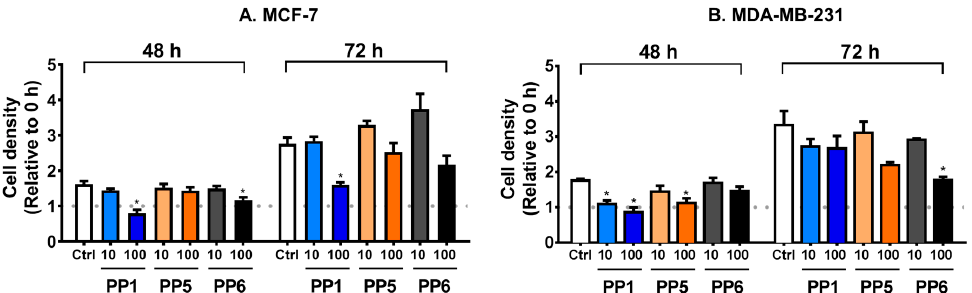
Figure 3. PP1 perturbs the proliferation of MCF-7 ( A ) and MDA-MB-231 ( B ) cells. After serum starvation, cells were treated with vehicle alone (Ctrl), PP1, PP5, or PP6 (10 or 100 µ M) in 10% FBS media for 48 or 72 h. At the corresponding time points, plates were subjected to a cell density assay. All treatment values were normalized against the 0-h group. The following symbol denotes a statistical significance when compared to the control group: *, p <